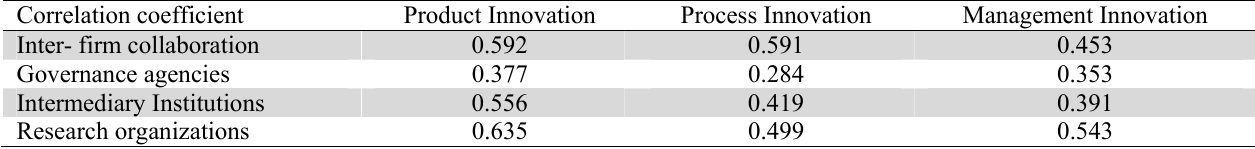
Correlation coefficient between Collaboration Network’ criteria and Innovation`s criteria Correlation